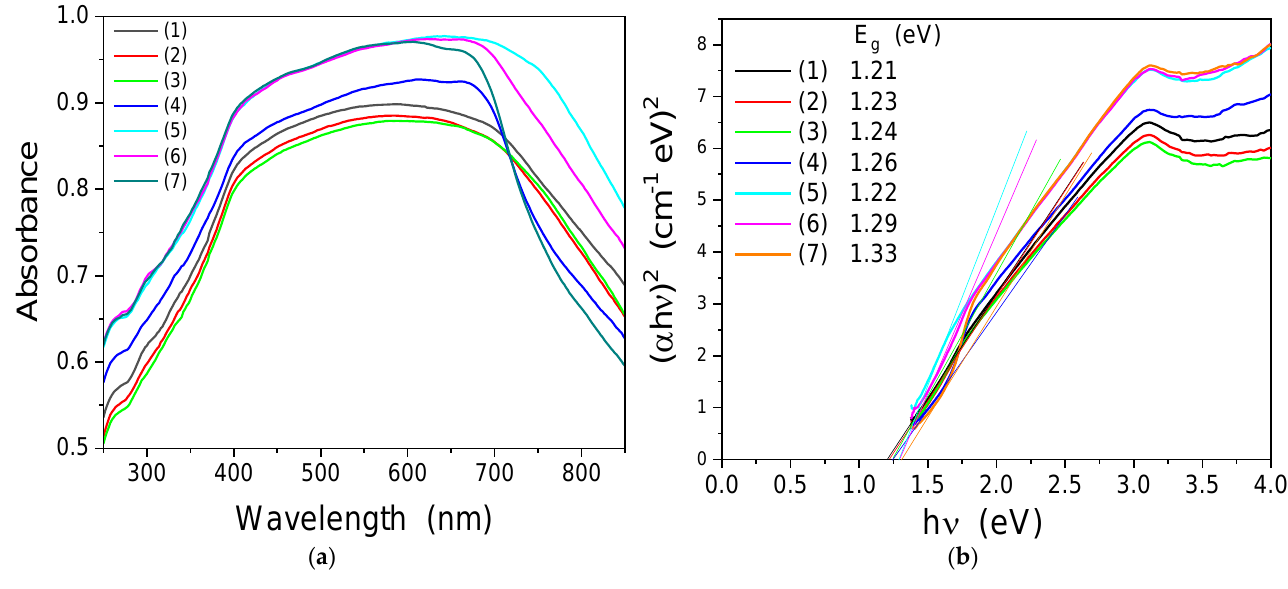
Figure 5. ( a ) UV-Vis absorption spectra and ( b ) Tauc’s plot of the of Zn 0.6 Co 0.4 Fe 2 O 4 @SiO 2 (1), Ni 0.1 Zn 0.5 Co 0.4 Fe 2 O 4 @SiO 2 (2), Ni 0.2 Zn 0.4 Co 0.4 Fe 2 O 4 @SiO 2 (3), Ni 0.3 Zn 0.3 Co 0.4 Fe 2 O 4 @SiO 2 (4), Ni 0.4 Zn 0.2 Co 0.4 Fe 2 O 4 @SiO 2 (5), Ni 0.5 Zn 0.1 Co 0.4 Fe 2 O 4 @SiO 2 (6) and Ni 0.6 Co 0.4 Fe 2 O 4 @SiO 2 (7) samples at 1000 °C. The band gap energy values are in the range 1.21 – 1.49 eV, are lower than that of NiFe 2 O 4 (2.2 eV), ZnFe 2 O 4 (1.91 eV) and CoFe 2 O 4 (2.31 eV), and are comparable to those reported for CoFe 2 O 4 xerogel calcined at 500 °C (1.5 eV) [33,50]. The band gap of our samples was also lower than those of Ni x Co 1-x Fe 2 O 4 (1.37–1.78 eV) obtained by copre- [52]. The optical band gap of the samples is due to the d-d transition. The crystal field splits the d level in the e g and t 2g levels and the band gap energy depends on octahedral (B) and tetrahedral (A) sites. The band gap energy, in the case of the octahedral site, is the octahedral (B) and tetrahedral (A) sites. In the XRD data, the peaks corresponding to